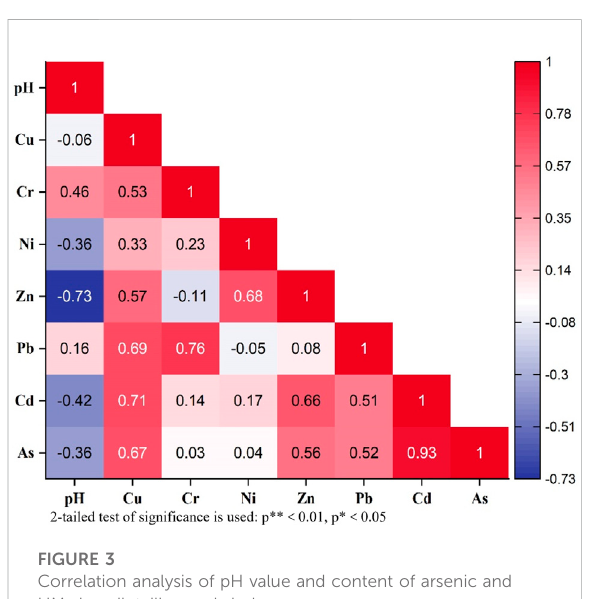
FIGURE 3 Correlation analysis of pH value and content of arsenic and HMs in soil, tailing and